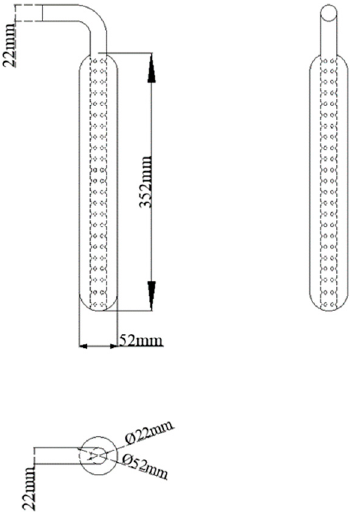
Figure 18. Adsorption bed structure.